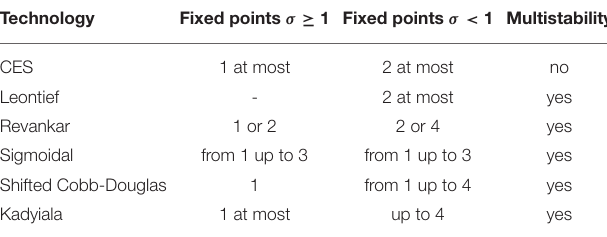
TABLE 1 | steady states and multistability phenomena in BK model.